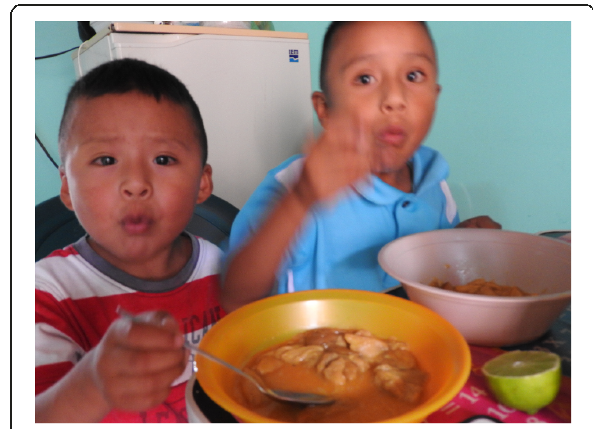
Fig. 4 Saúl and Junior, Wixarika children eating Amanita caesarea complex with